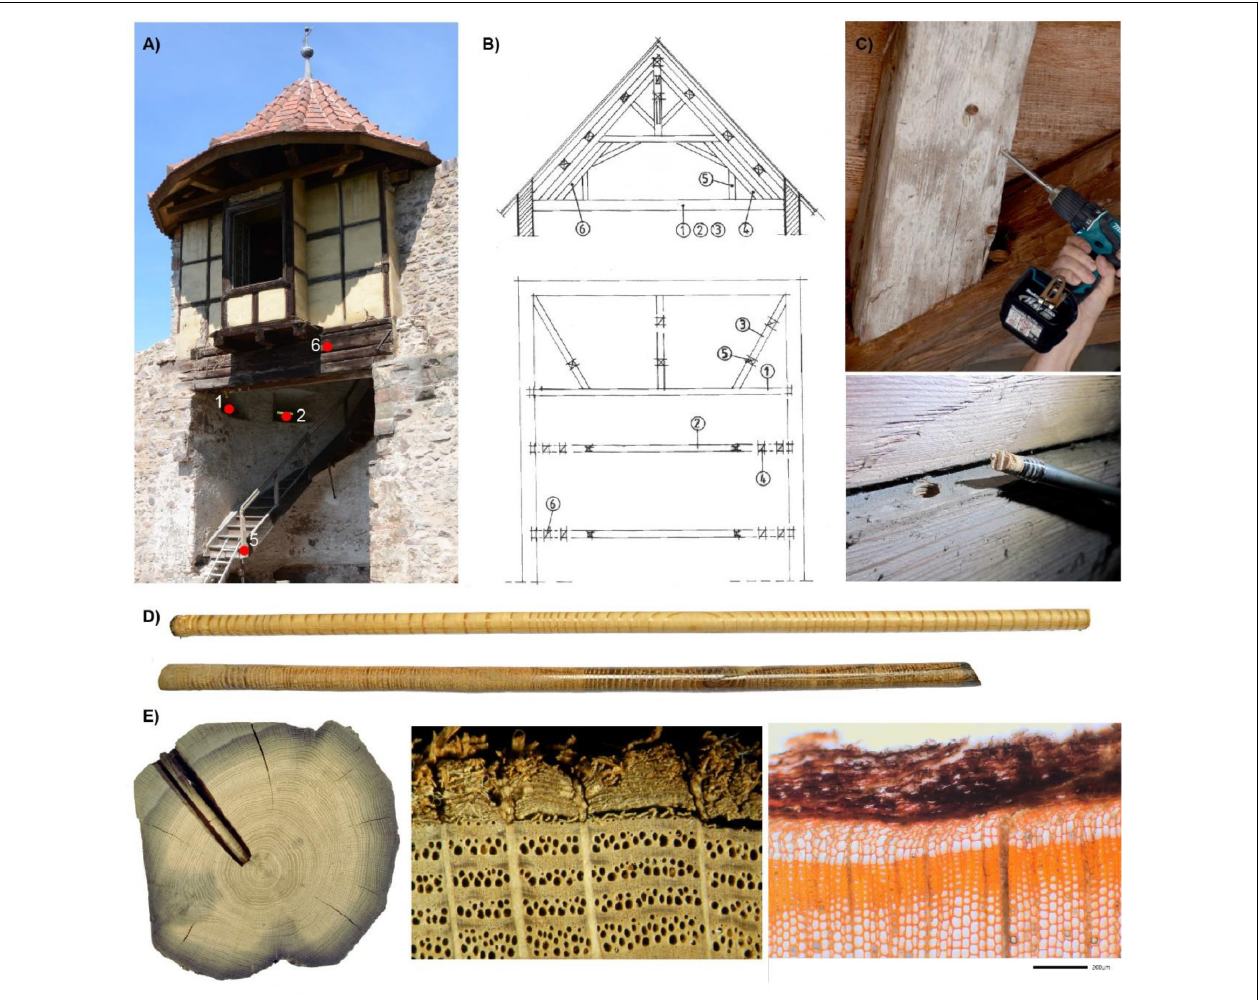
FIGURE 6 | Documentation of the location of historical timber on (A) photograph or (B) construction plans sampled with (C) increment borers and cordless drill. (D) The retrieved cores with (E) sapwood and heartwood (drilled oak disk; left ) and waney edge ( center and right ) with parts of the bark, earlywood vessels (oak; center ) and earlywood cells (pine; right ) are